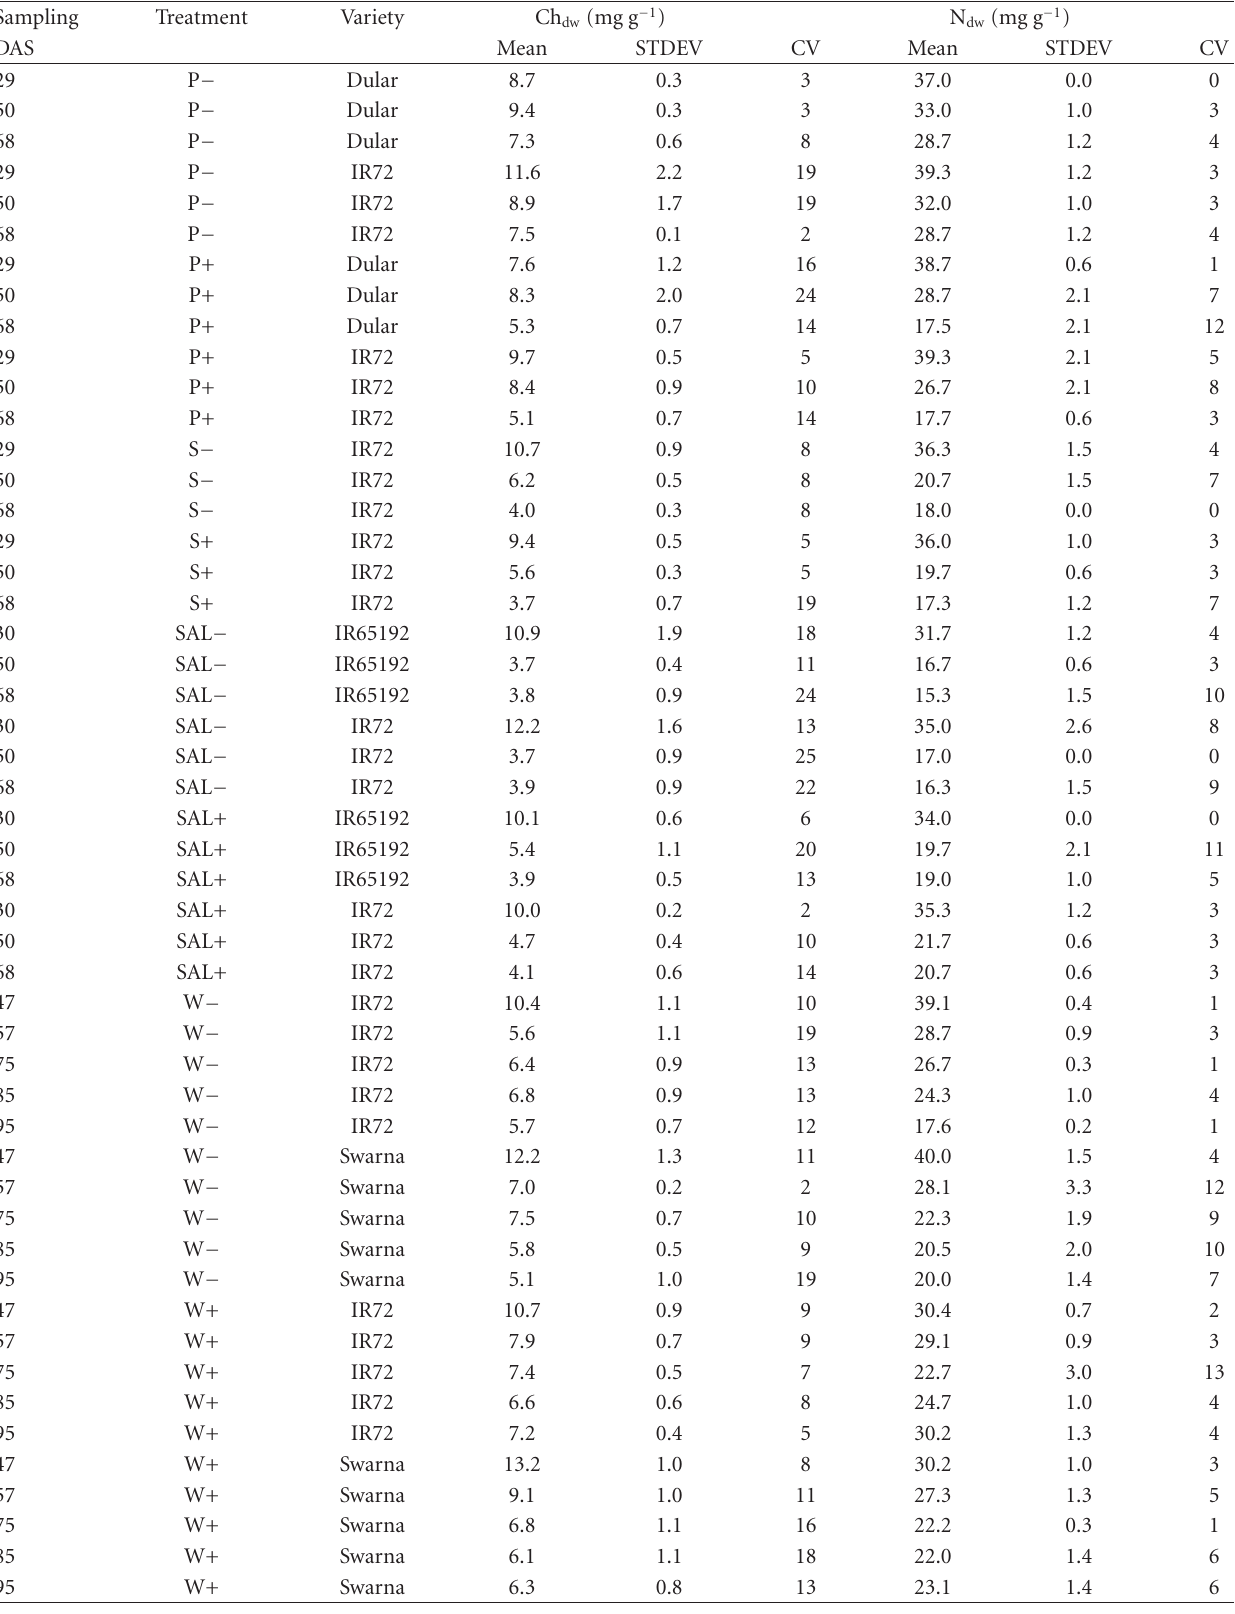
Table 5: Descriptive statistics (mean, standard deviation, and coe ffi cient of variation) for chlorophyll and leaf N concentration based on dry weight (Ch dw and N dw ) dependent on sampling time (days after seeding: DAS), stress treatment, and variety